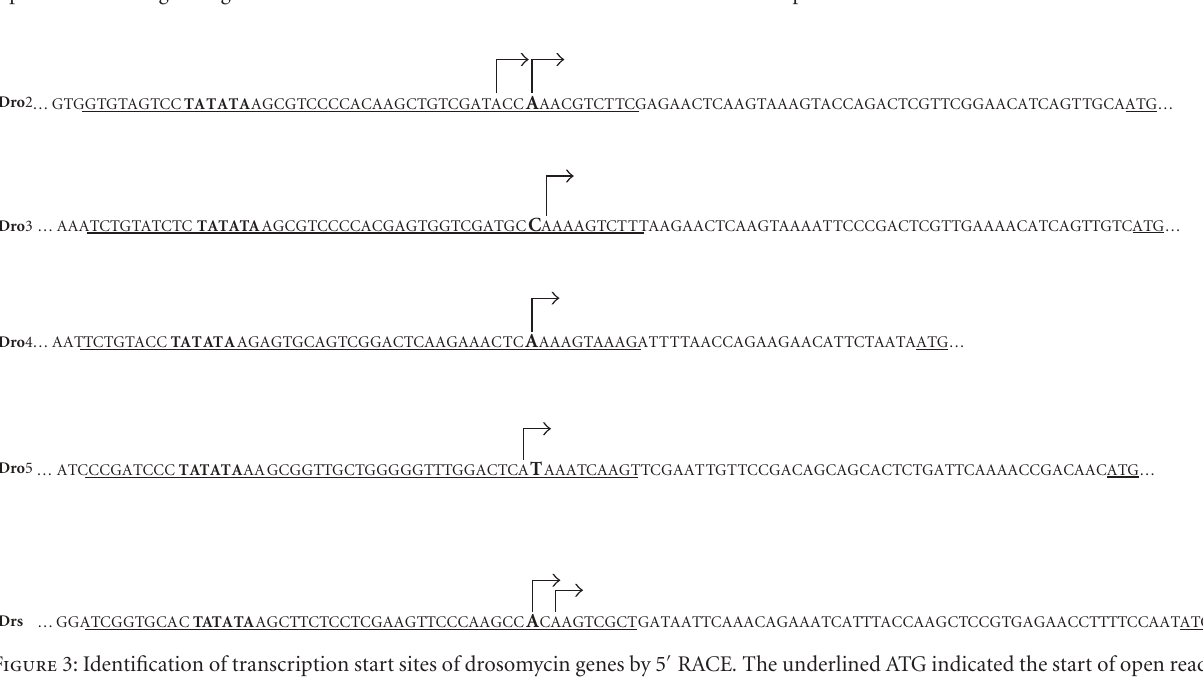
Figure 3: Identification of transcription start sites of drosomycin genes by 5 (cid:2) RACE . The underlined ATG indicated the start of open reading frames (ORFs). Arrows indicated the transcription start sites and transcriptional directions. The putative core promoters predicted by NNPP software were underlined. And the predicated transcription start sites were indicated in larger fonts. The TATA boxes in the promoter were shown in